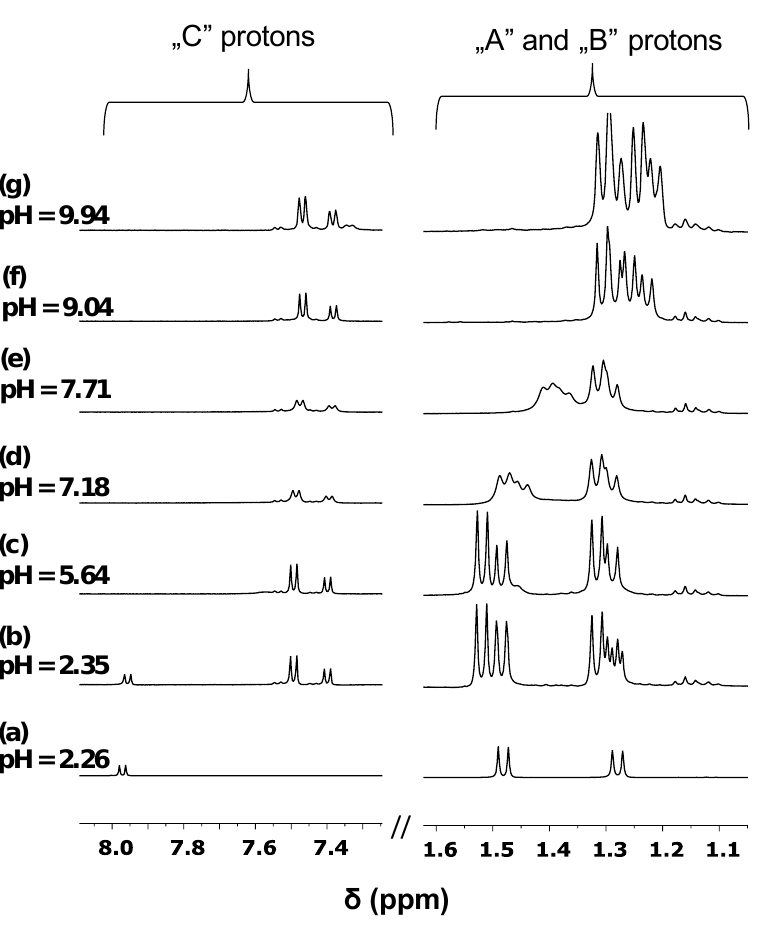
Figure 4. 1 H NMR spectra registered for the H + – (L1) − ( a ) and [Co(tren)] 3+ – (L1) − system ( b – g ) at different pH values. 1 H NMR spectra obtained for the samples containing both [Co(tren)] 3+ and Pd(II)